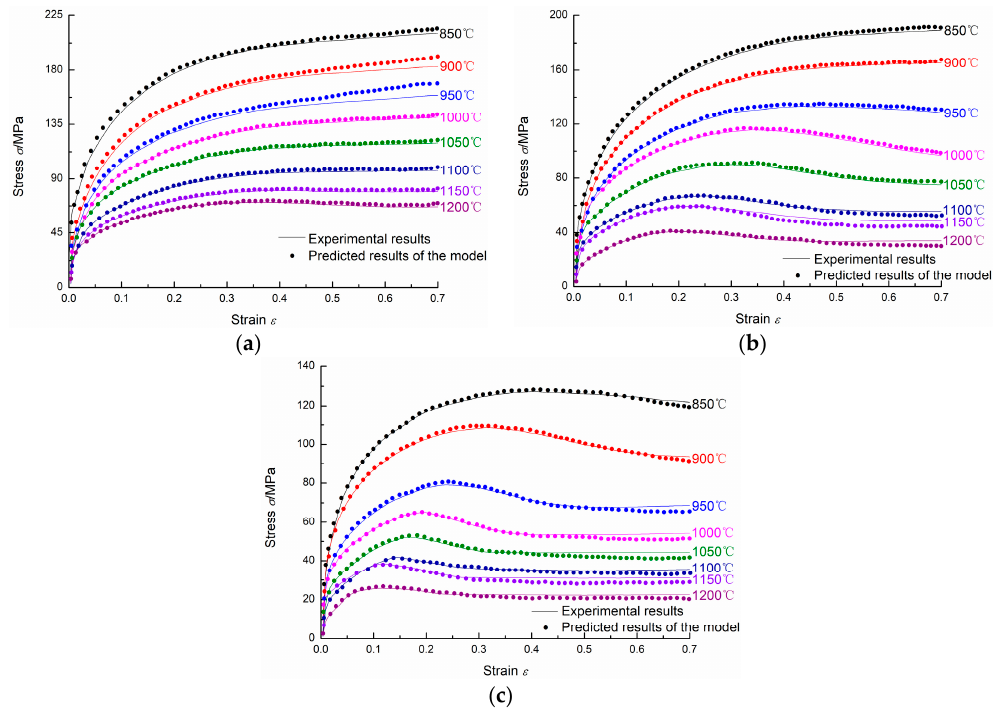
Figure 15. The comparison between experimental results and predicted results of the model: ( a ) 1/s; ( b ) 0.1/s; ( c ) 0.01/s.